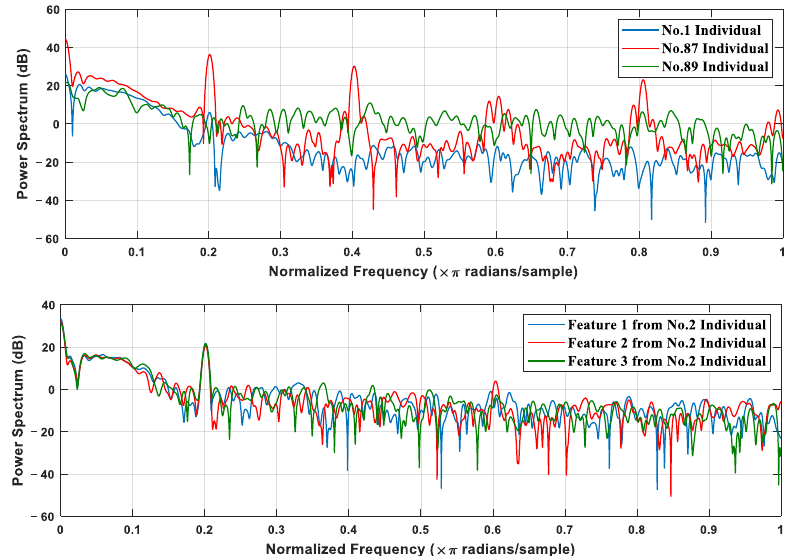
Figure 5. Spectrum estimation curves of ECG signals from different individuals and the same individual.